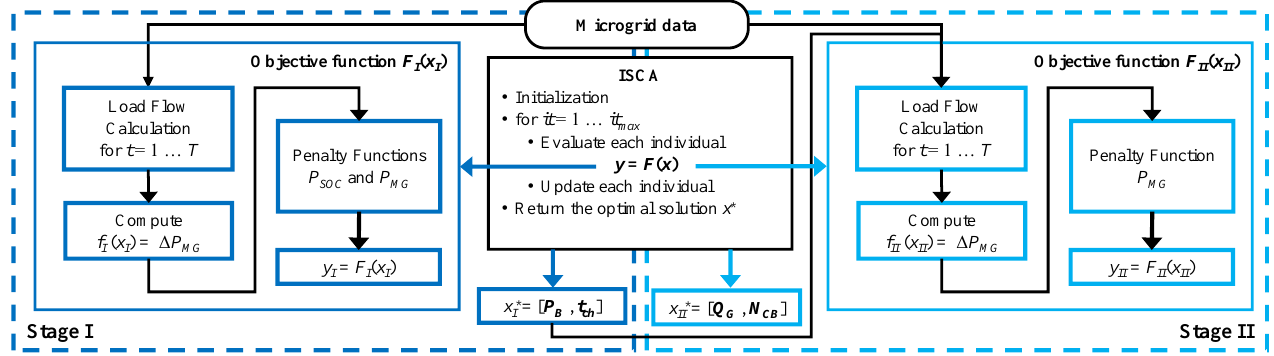
Figure 1. Two-stage Active-Reactive Power Coordinated Optimization Flowchart.